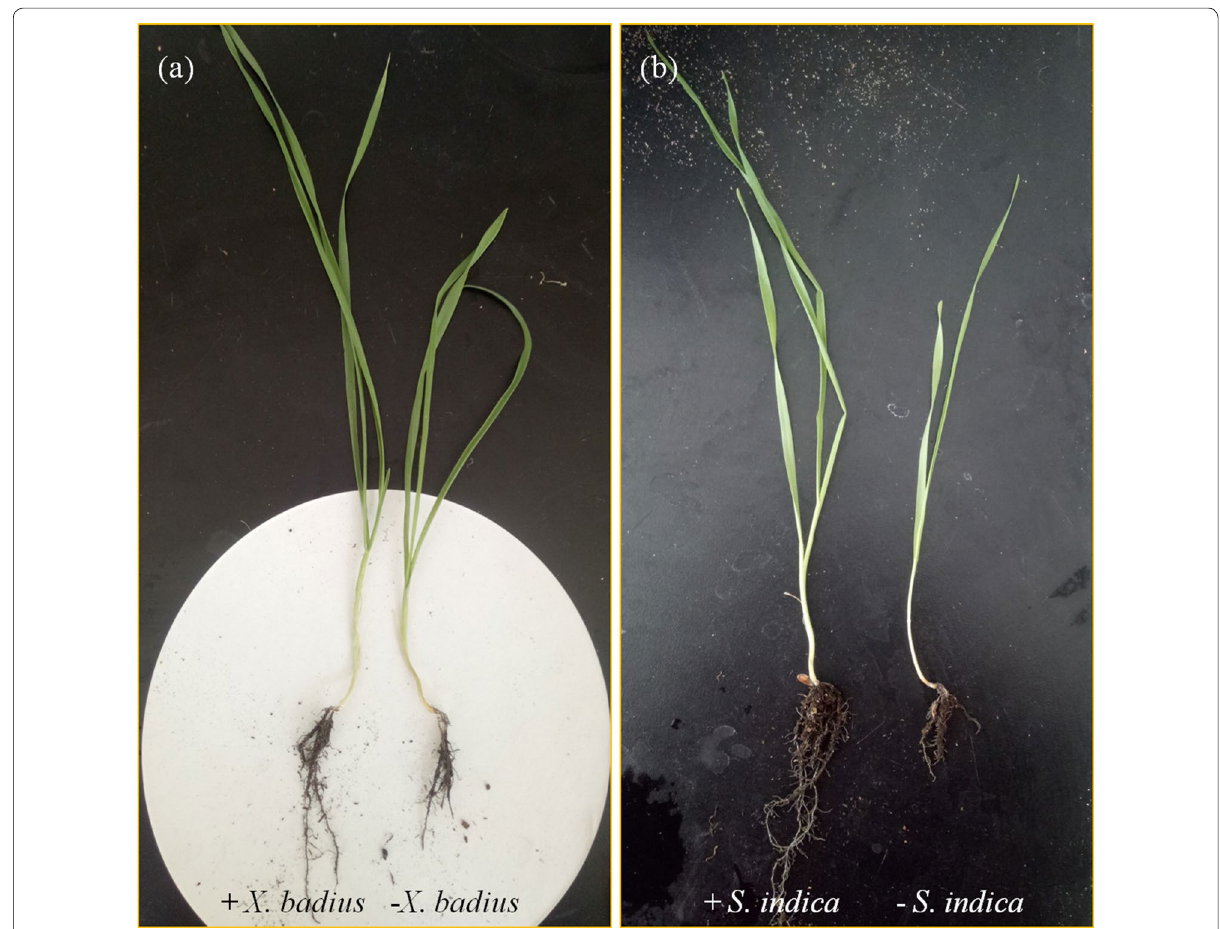
Fig. 3 Typical phenotype of L. multiflorum seedlings 4 weeks after inoculation or non-inoculation with X. badius ( a ) and S. indic a ( b